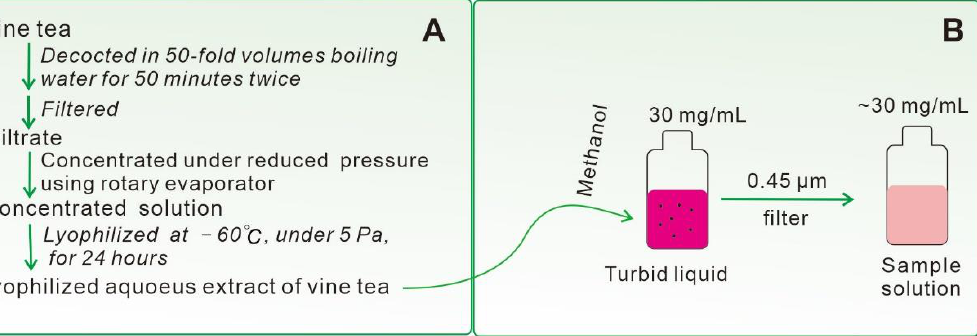
Figure 6. Preparation of lyophilized aqueous extract of vine tea ( A ) and its sample solution ( B